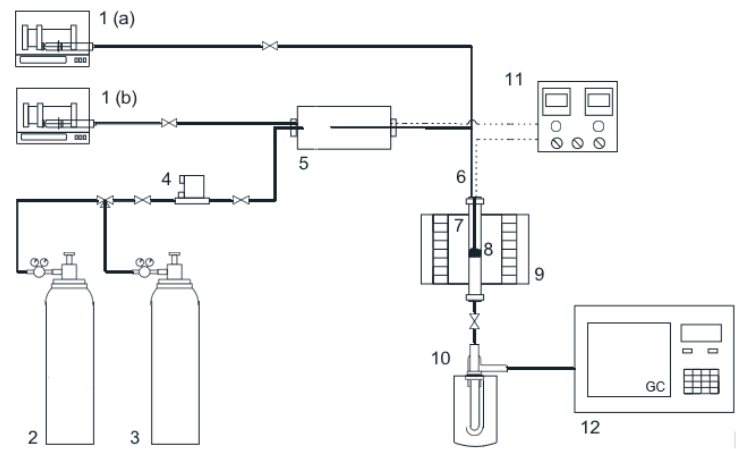
Figure 11. Schematic diagram of steam reforming experimental setup: (1) syringe pump—(a) tar model (b) water; (2) 10% H 2 /N 2 cylinder; (3) N 2 cylinder; (4) mass flow controller; (5) turbo vaporizer; (6) K-type thermocouple; (7) stainless steel tubular reactor; (8) catalyst/SiC; (9) furnace; (10) condenser; (11) temperature controller; (12) GC-TCD.